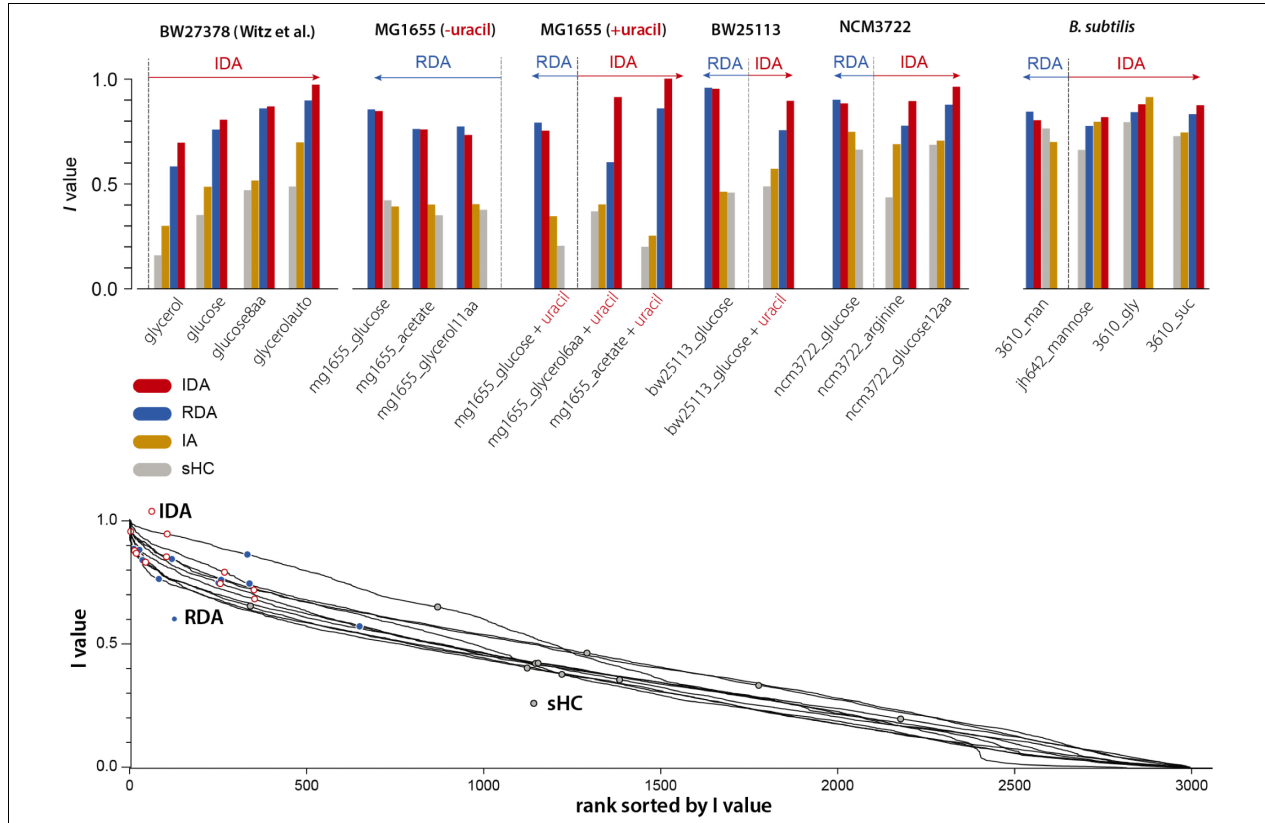
FIGURE 3 | We applied the I -value analysis proposed by Witz et al. (2019) to 4 models (RDA, IDA, IA, and sHC) using 15 experimental datasets that we produced (see Supplementary Methods ), and the 4 datasets published by Witz et al. (2019). In the top bar graphs, the 4 variables are λ , (cid:49) d , δ ii , S b for both the IDA model and λ , δ id , δ ii , s i for the RDA model (see the choice of variables in Supplementary Methods ). The length of the arrows indicate how much IDA or RDA model is favored by the